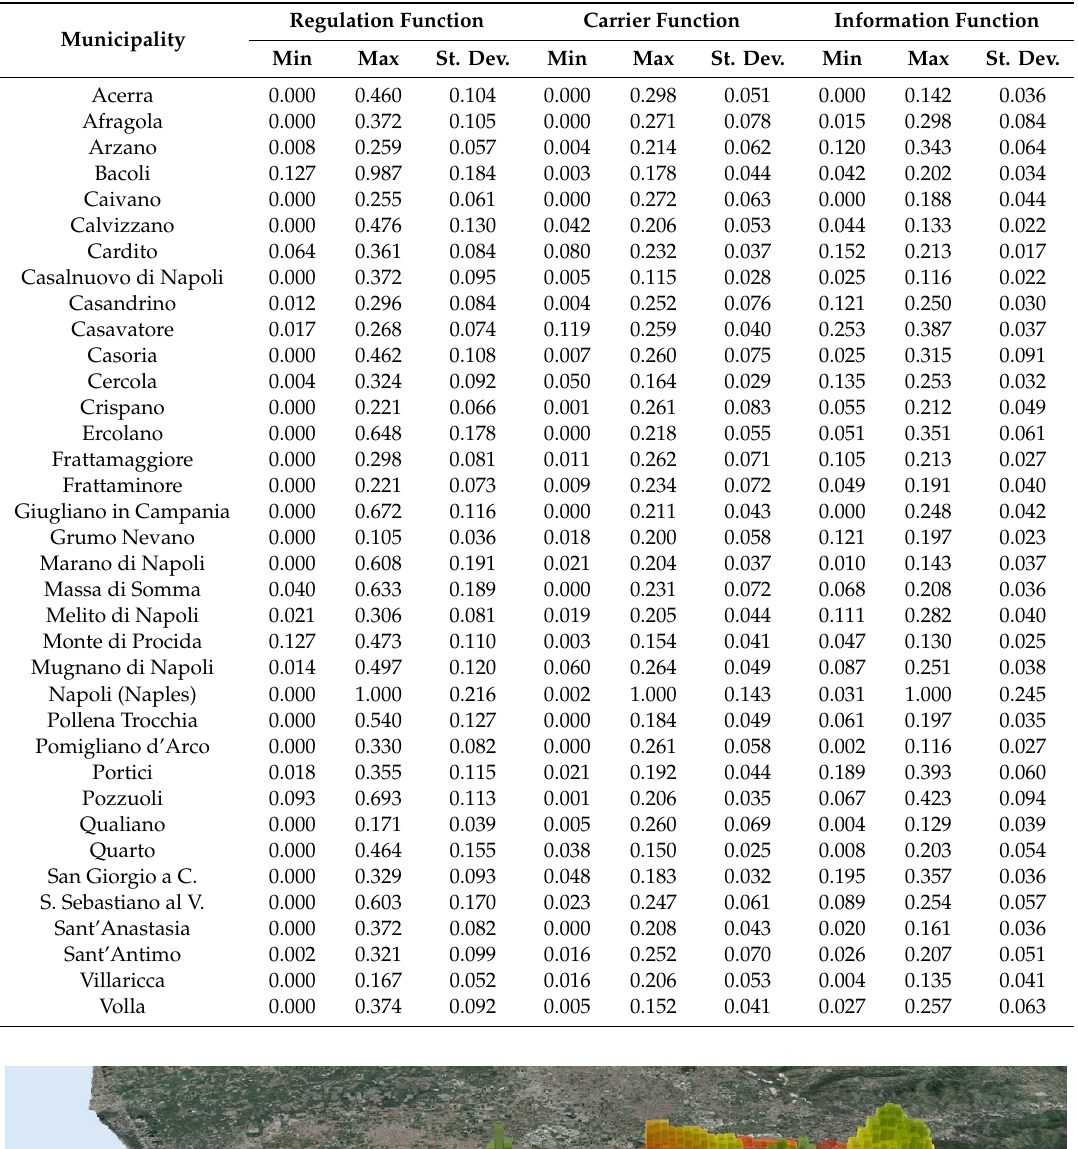
Table 2. Urban Ecosystem Services values standardised per municipality.